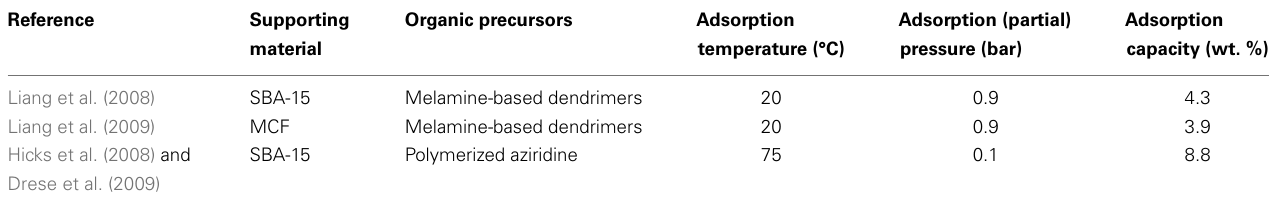
Table 4 | Key parameters for Class 3 immobilized amine adsorbents